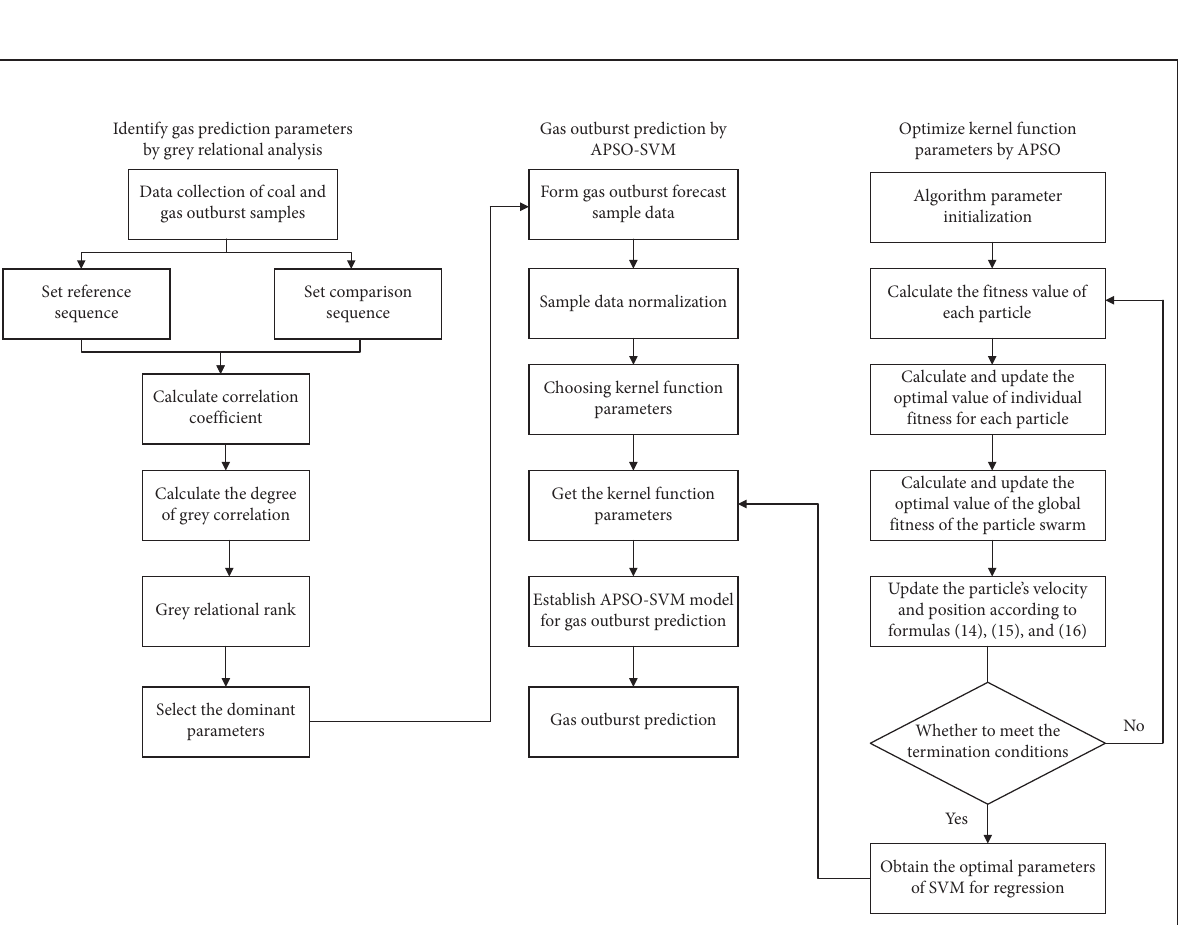
Figure 2: The construction of the gas outburst risk prediction based on grey relational analysis and using SVM optimized by APSO algorithm